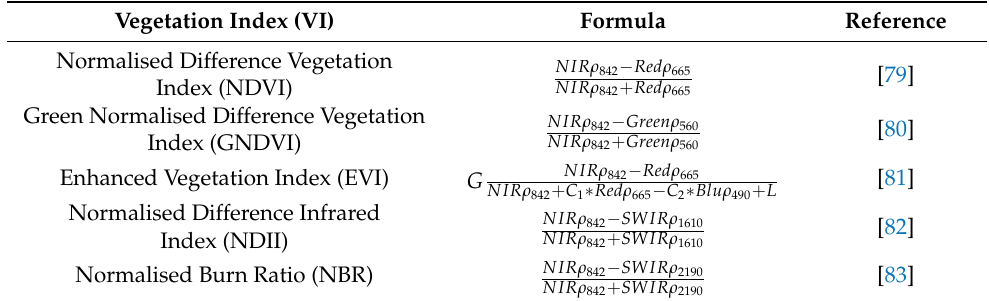
Table 2. Vegetation indices (VIs) adopted in this work and computed in the Google Earth Engine